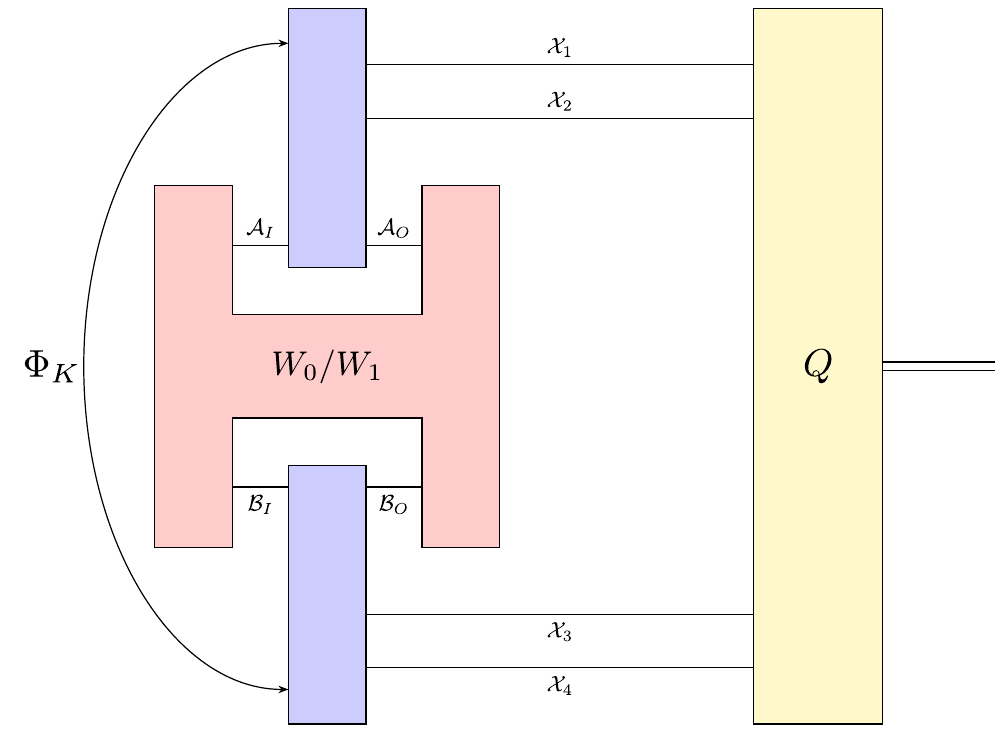
Figure 3. A schematic representation of the setup for distinguishing between process matrices W 0 and W 1 . The discrimination strategy is constructed by using the quantum